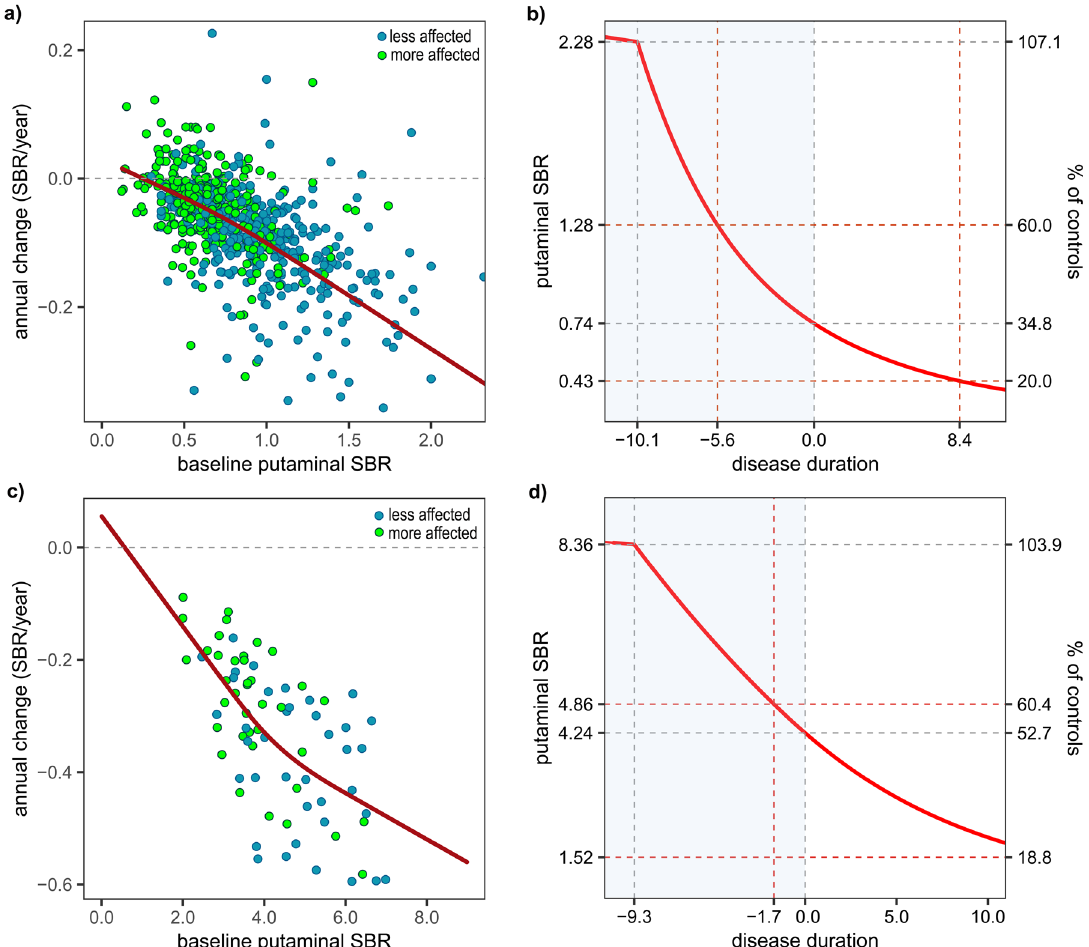
Fig. 2 Annual changes in putaminal DAT SBRs as a function of baseline levels and estimated temporal trajectories in sPD patients. Fitted curves on the scatter plots were obtained with the RCS model in PPMI ( a ) ( 123 I-FP-CIT SPECT) and GSH ( c ) ( 18 F-FP-CIT PET) cohorts. Outliers beyond the fi rst or third quartile ± 3 × interquartile range (5 putamen, sPD group of PPMI cohort) are not shown. All outliers were included in the calculation of temporal trajectories. Temporal trajectories in the PPMI ( b ) and GSH ( d ) cohorts were acquired with a modi fi ed Euler ’ s method for solving the fi rst-order differential Table 1 and Fig. 4c). In comparisons between the sPD and LRRK2